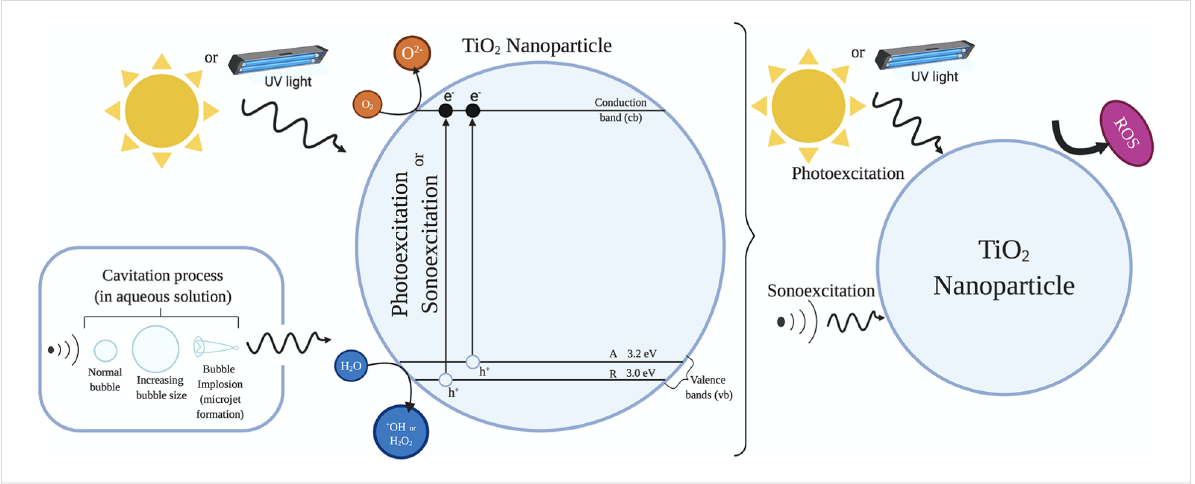
Figure 6: Illustration of ROS generation by TiO 2 nanomaterials by photosensitization and sonosensitization techniques. (Figure 6 was adapted from [110] (© 2018 J. Bogdan et al., published by Springer Open, distributed under the terms of the Creative Commons Attribution 4.0 International License,